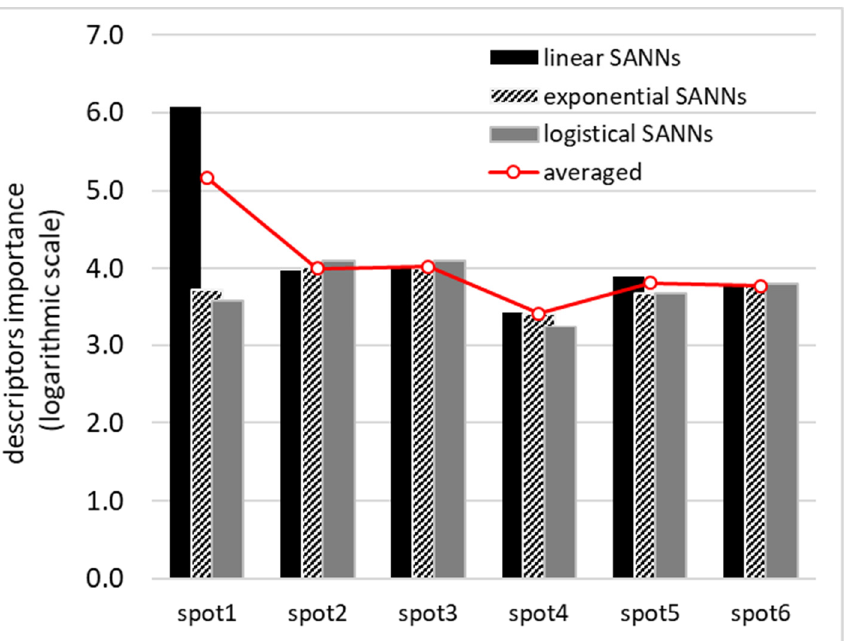
Figure 8. Results of sensitivity analysis providing information about importance of the descriptors distributions.